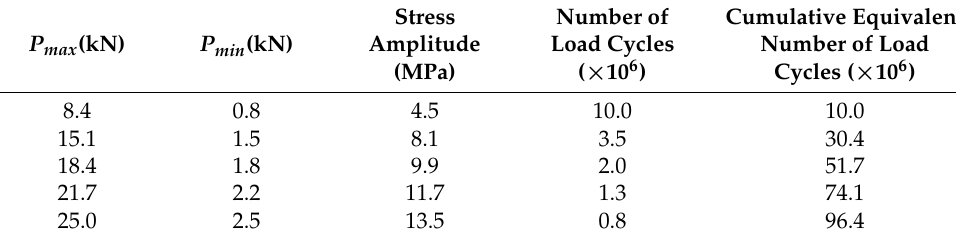
Figure 18. The fatigue test. Table 6. Specific load and stress amplitude of fatigue